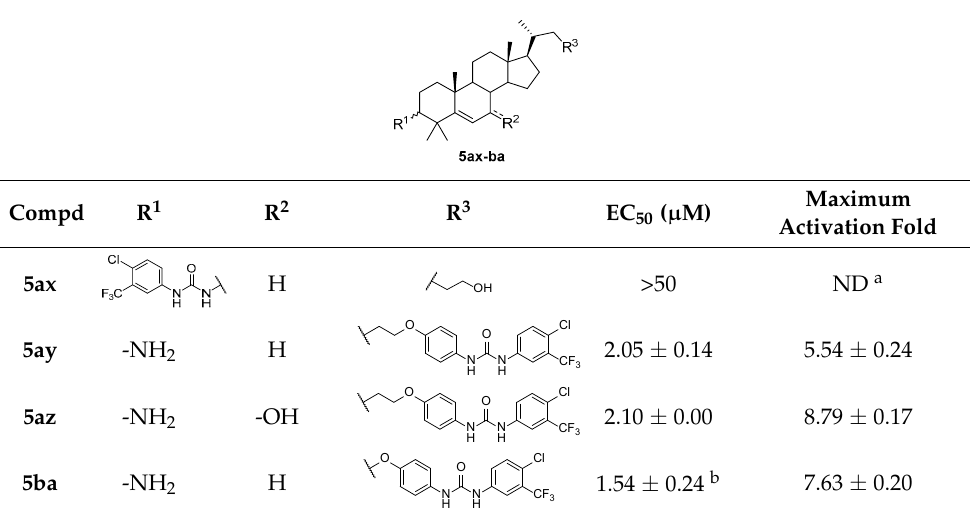
Table 4. SHP1-activating effects of compounds 5ax-ba .